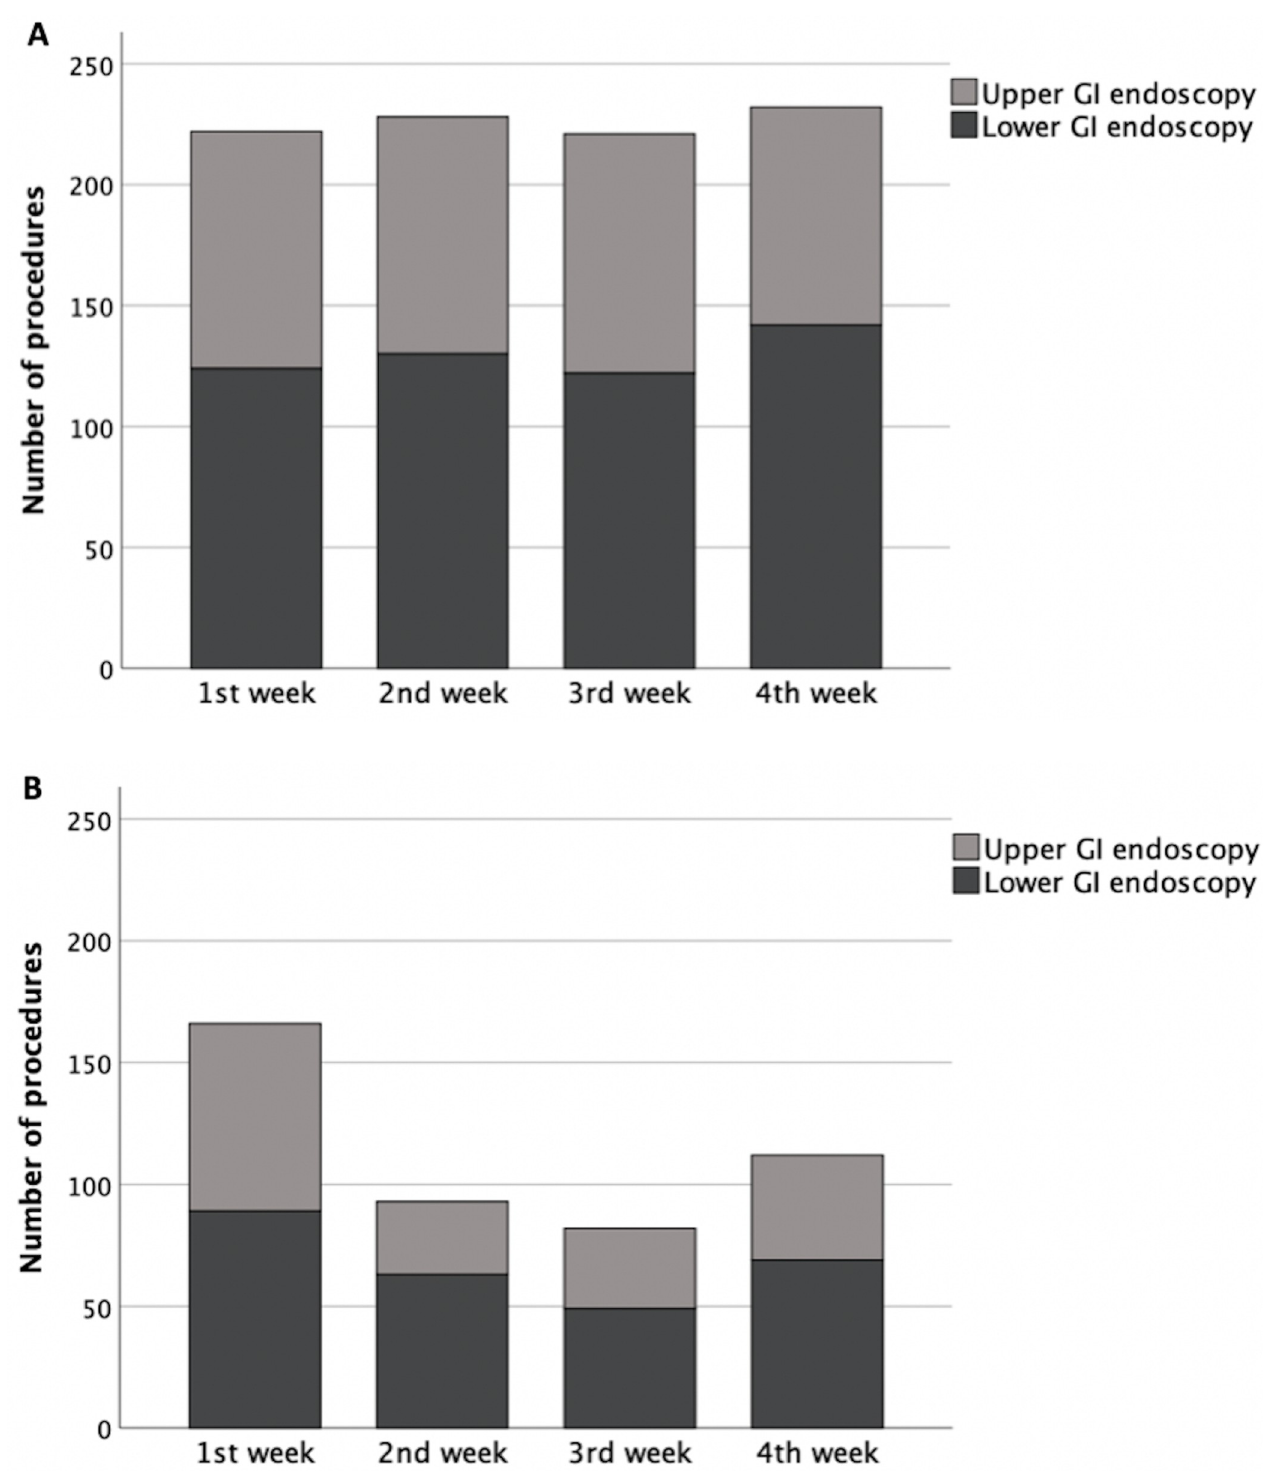
Fig 1. Number and type of endoscopies according to gastrointestinal (GI) upper and lower procedures performed in the pre-lockdown (A) and lockdown (B) cohorts.